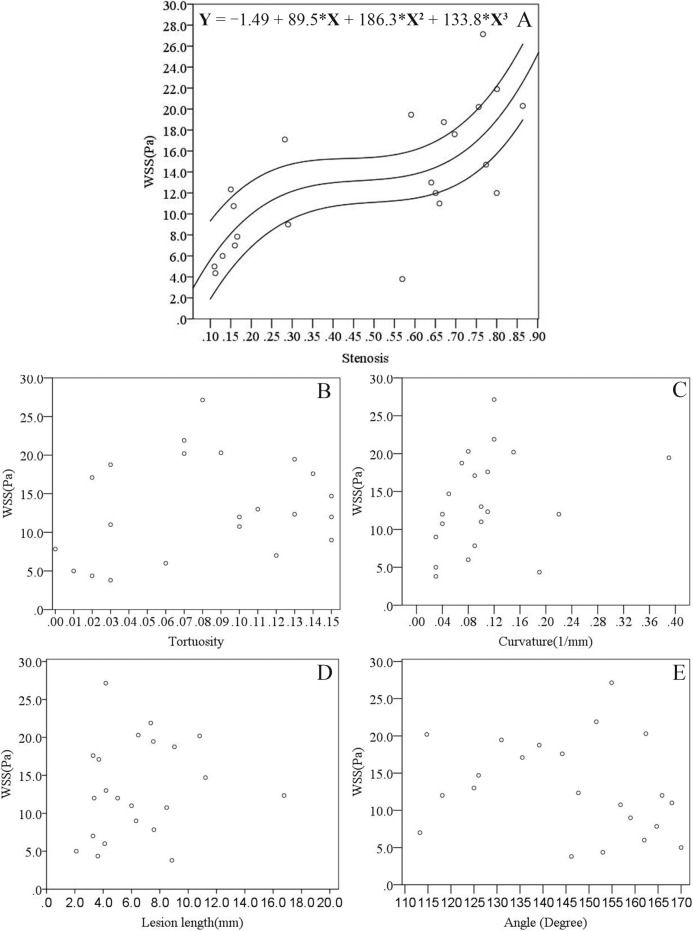
Relationship among stenosis severity, tortuosity, curvature, angle, lesion length with wall shear stress in the reconstructed patient-specific coronary arteries.A: effect of stenosis severity (percent diameter stenosis) on maximum wall shear stress; B: effect of tortuosity on maximum wall shear stress; C: effect of curvature on maximum wall shear stress; D: effect of lesion length on maximum wall shear stress; E: effect of angle of the lesion segment on maximum wall shear stress. Third-order nonlinear cur fit with 95% confident interval is shown in A with R2 equals 0.521.